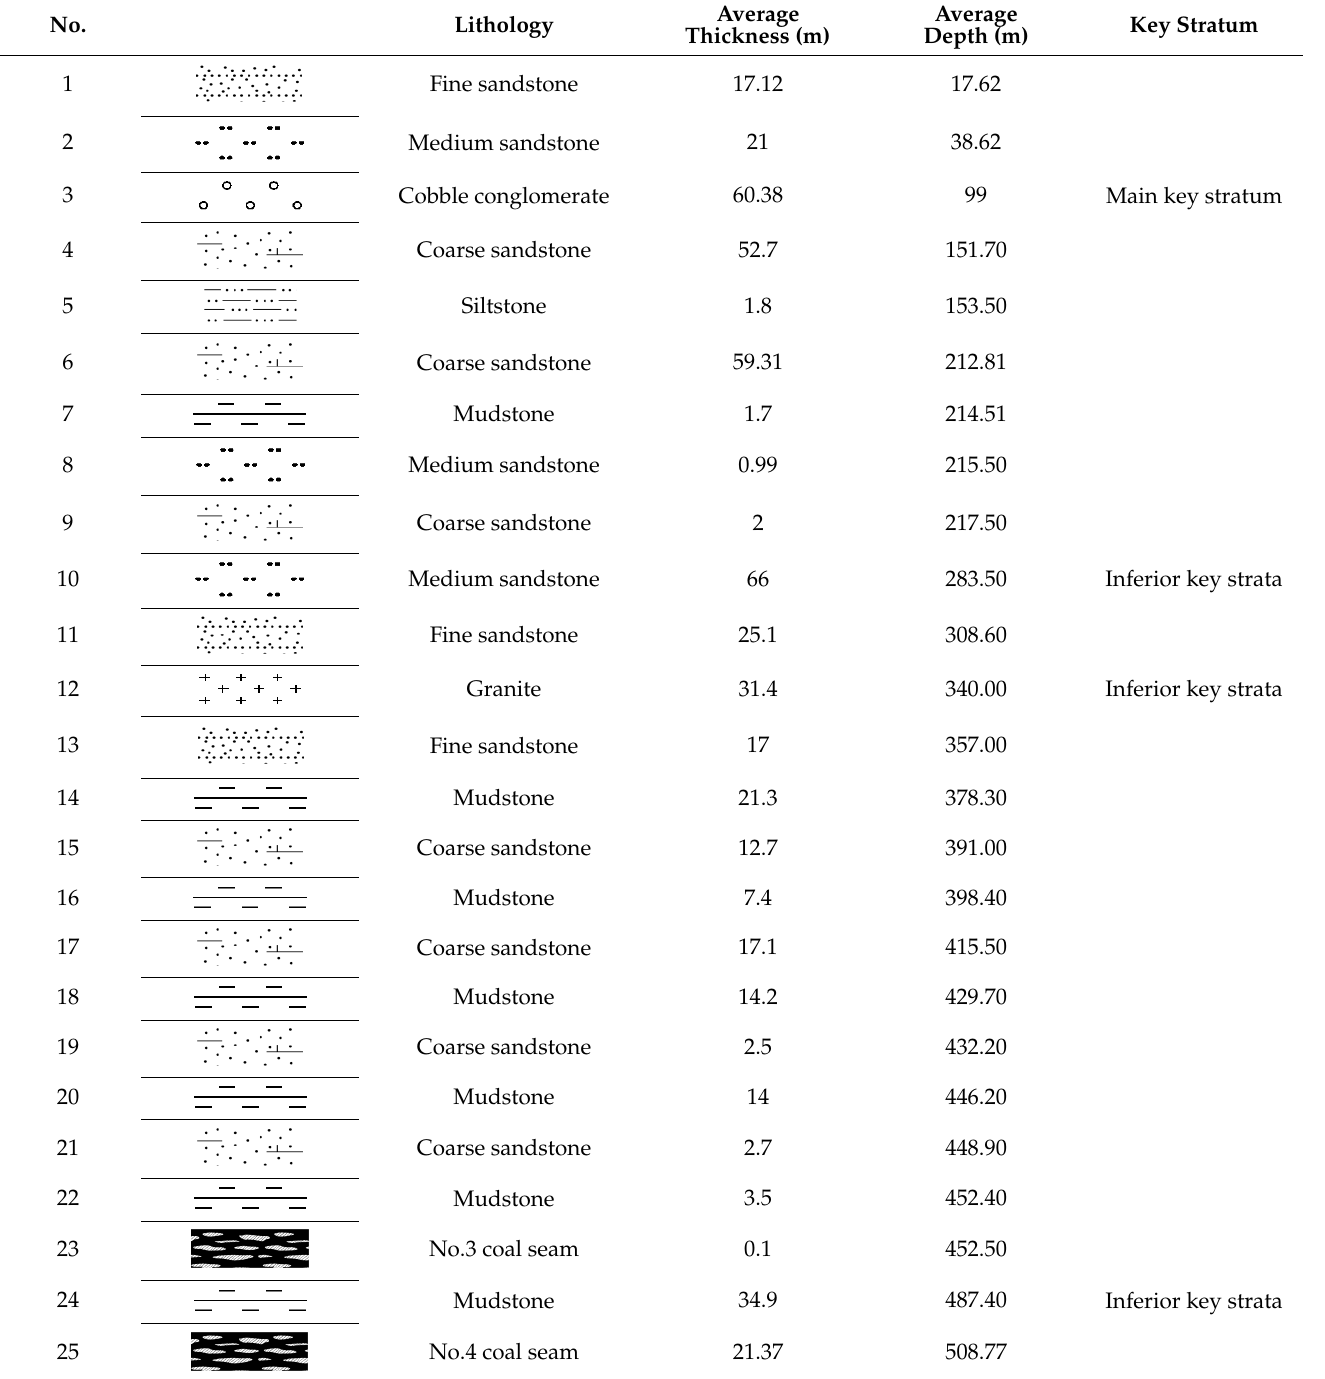
Table 2. Lithological characteristics at the No. 2 panel area investigated by borehole.